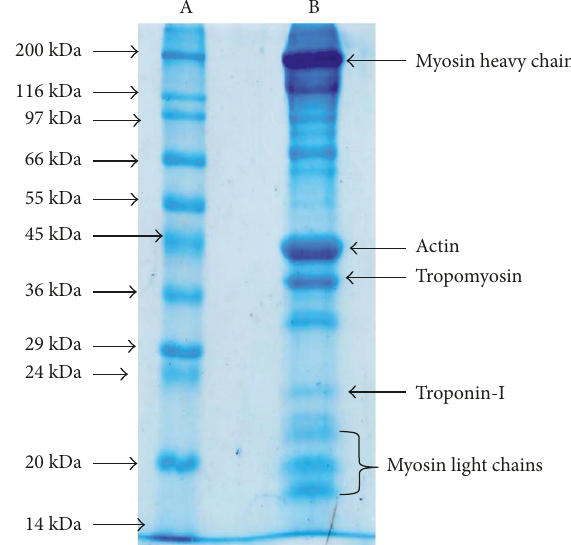
Figure 1: SDS-PAGE profile of natural actomyosin from Catla catla (lane A: standard molecular weight markers; lane B: natural actomyosin